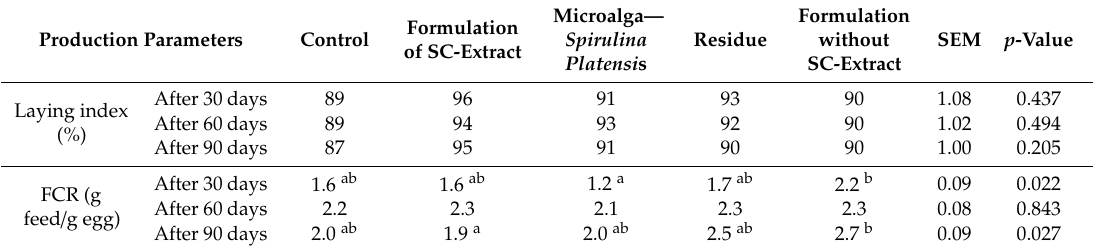
Table 4. Production parameters of laying hens during the experiment.